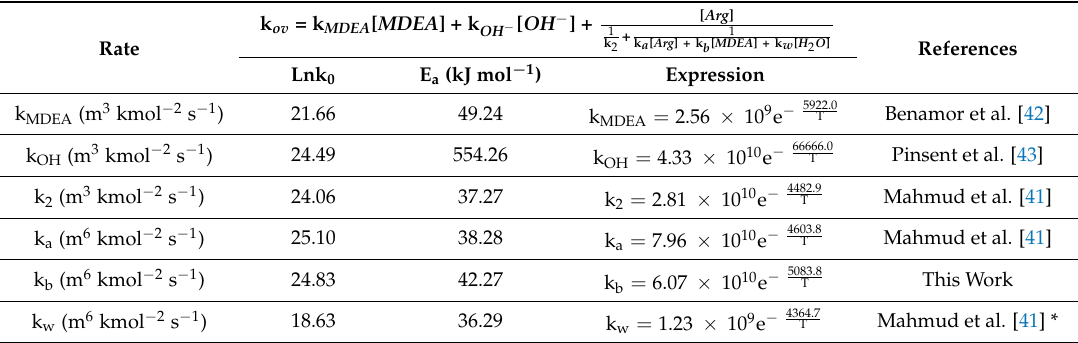
Table 5. Summarized kinetics rate constants for CO 2 -MDEA-Arg reaction using Zwitterion Mechanism.